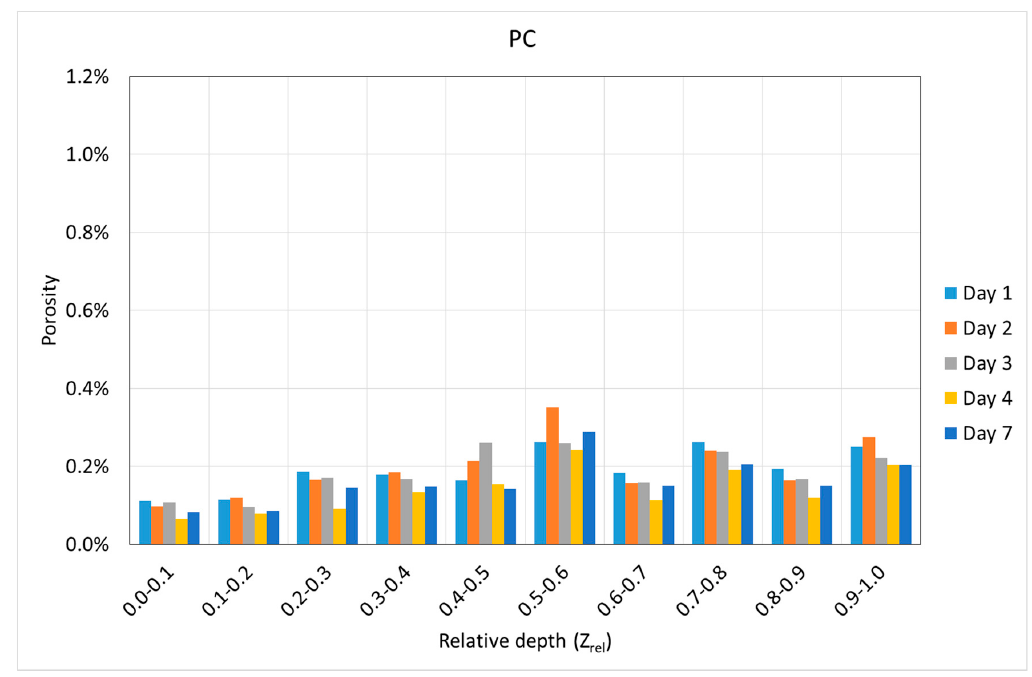
Figure 11. Variation of the porosity in plain concrete (PC) according to the depth and age.